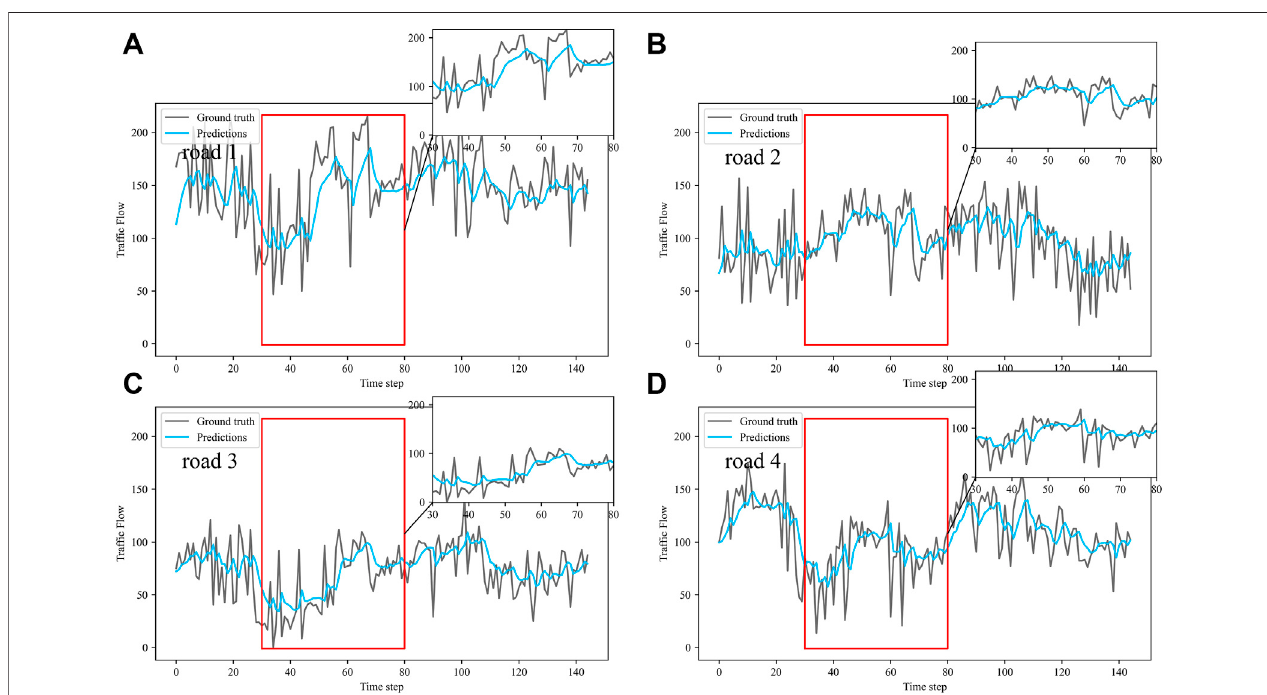
FIGURE12| VisualizationofGruGcnmodelpredictionresultsonpeakdataset. (A) road1meansGudunRoad. (B) road2meansFengtanRoad. (C) road3means Yile Road. (D) road 4 means Jingzhou Road.